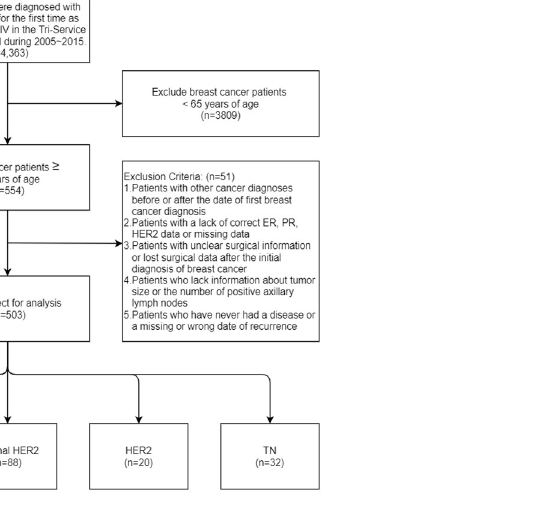
Fig 1. Flowchart presenting the process of selecting the study